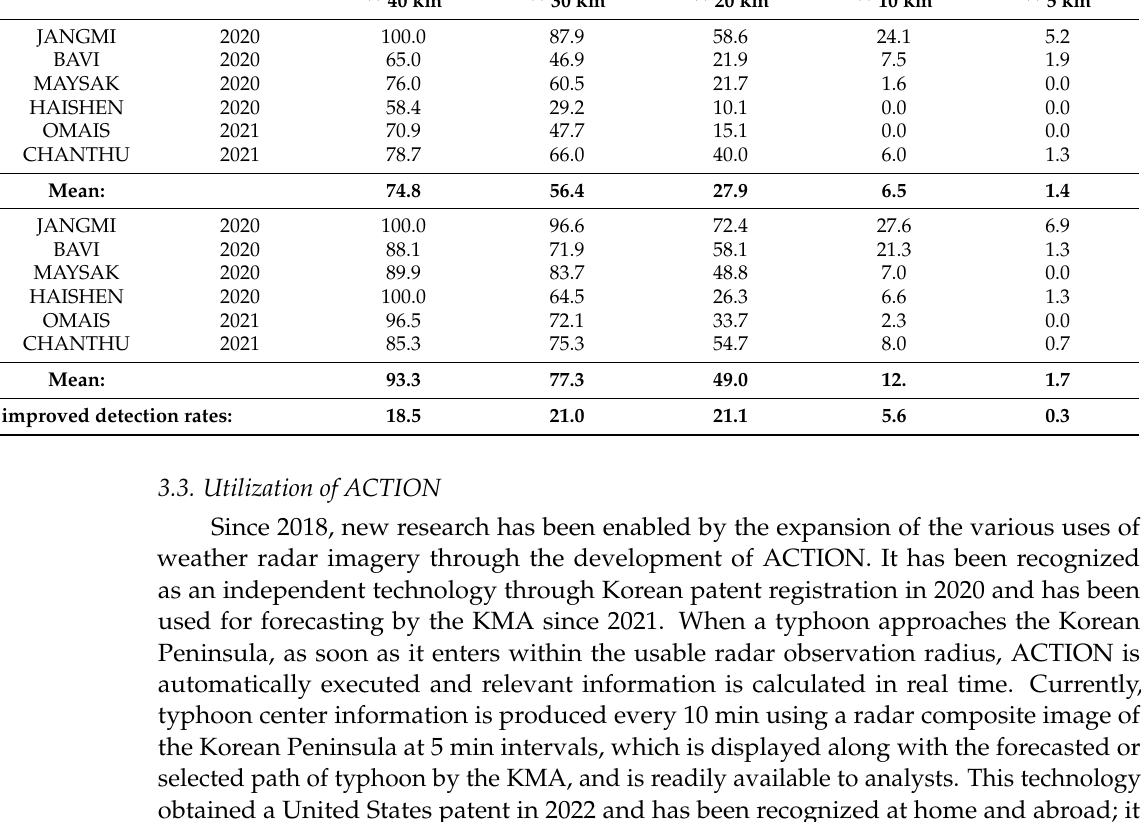
Table 3. Detection rate by error distance of ACTION results according to radar image interval improvement (from 10 to 5 min) for typhoons that affected the Korean Peninsula between 2020–2021. Image Interval